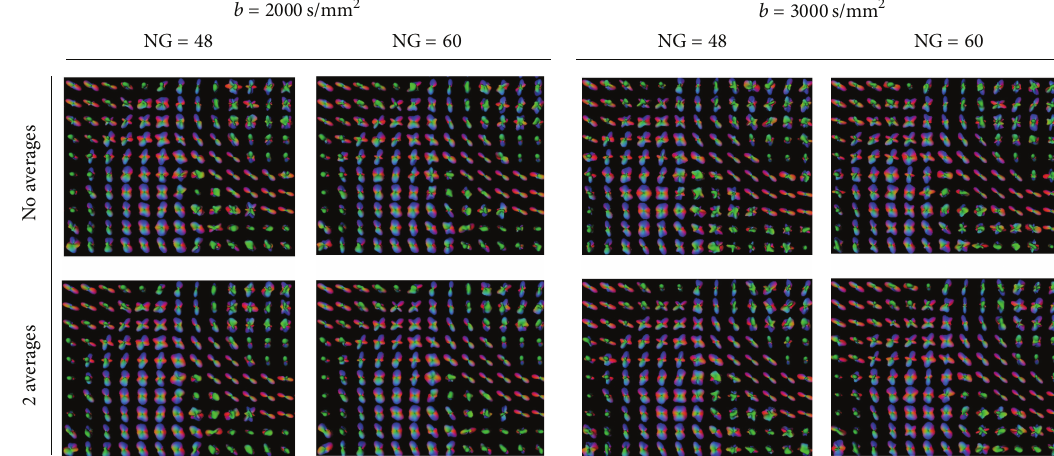
Figure 14: The effect of the averaging of the data at 𝑙 = 6 in a Q-ball glyph representation. There is not a significant difference between the quality of the data without and with averaging even at higher 𝑏